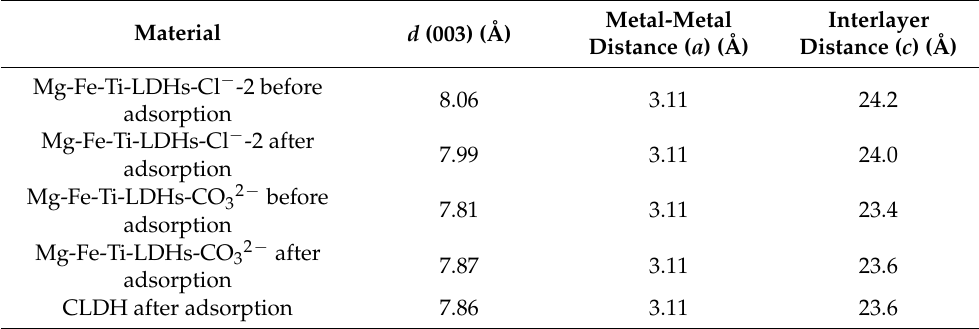
Figure 11. XRD pattern of Mg-Fe-Ti-LDHs-Cl − -2, Mg-Fe-Ti-LDHs-CO 32 − and Mg-Fe-Ti-CLDH after vanadate adsorption. Table 5. Crystal parameters of Mg/Fe/Ti-LDHs-Cl − -2, Mg/Fe/Ti-LDHs-CO 32 − and Mg/Fe/Ti- Table 5. Crystal parameters of Mg/Fe/Ti-LDHs-Cl − -2, Mg/Fe/Ti-LDHs-CO 3 2- and Mg/Fe/Ti-CLDH CLDH after adsorption of VO 3 − after adsorption of VO 3− .